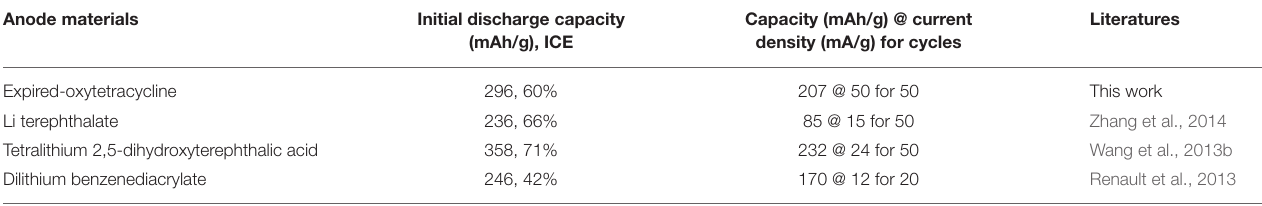
TABLE 1 | The comparison of performances of expired oxytetracycline with other analogous organic anode materials in literatures.